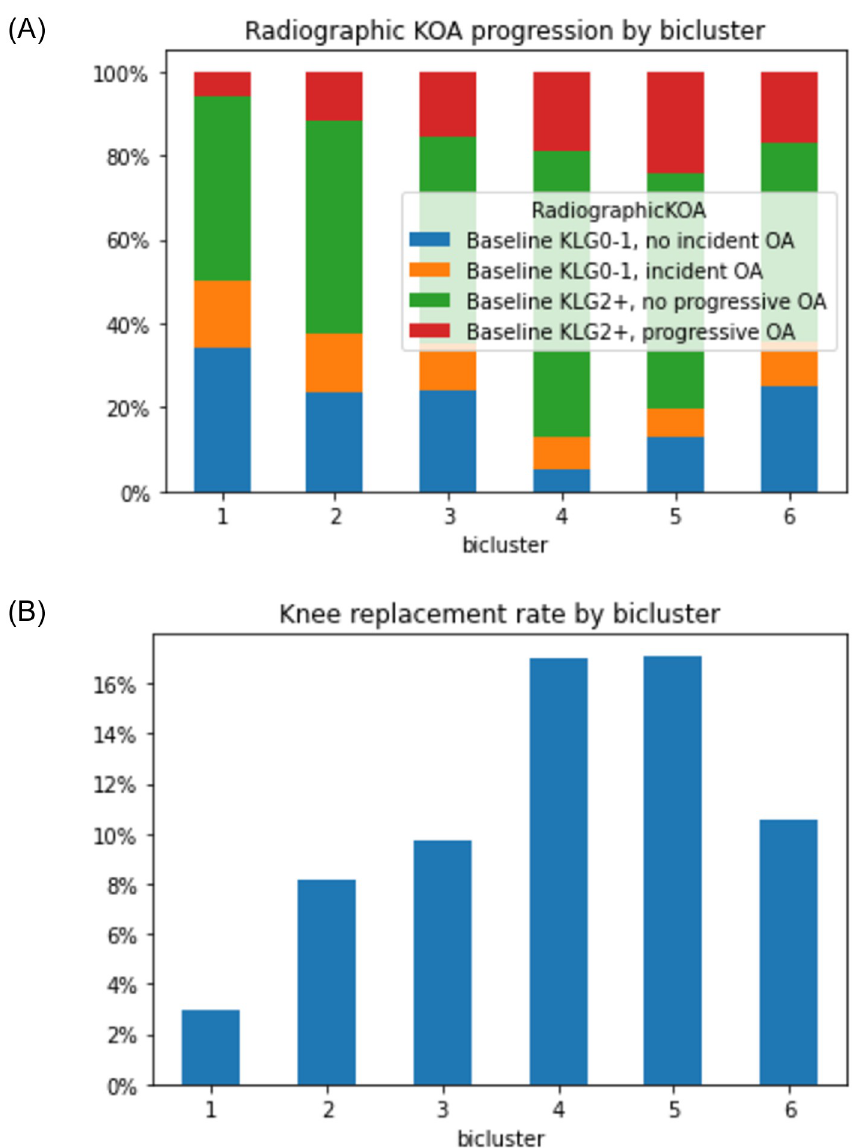
Fig 6. Structural progression by bicluster over 96 months. A. Progression based on Kellgren-Lawrence Grade (KLG) from baseline to 96 months; B. Progression based on receipt of a total knee arthroplasty (TKA) by 96 months. The x- axis indicates each of the six biclusters; the y-axis is the proportion of knees in each category of the legend. Incident and worsening rOA are summarized together in Fig 6A, where knees in blue do not have rOA at baseline and do not develop it over the study period; green indicates rOA at baseline without progression over the study period. Orange indicates development of new knee rOA, while red reflects progression of rOA over 96 months. The x-axis shows the 6 biclusters; knees in bicluster #4 and 5 have more prevalent and progressive rOA compared to the other biclusters. Knees without baseline or new rOA (blue) are more frequent in biclusters #1–3 and 6. Similarly, biclusters #4 and 5 had the most eventual TKA over the 96 months at around 16% (Fig 6B), while bicluster 1 had the fewest at only about 3%. Biclusters #2, 3, and 6 had rates between 8–10%.